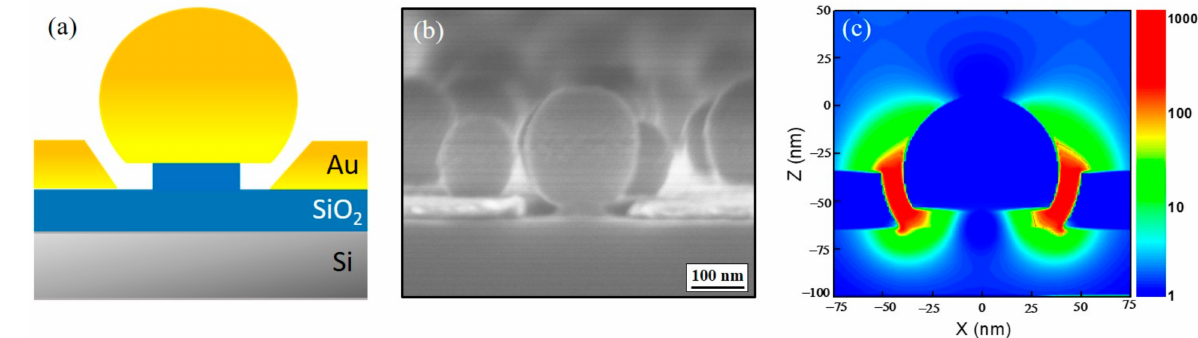
Figure 2. ( a ) Schematic illustration and ( b ) SEM image of an Au nanogap sample. ( c ) FDTD simulation result showing the enhancement of |E| 2 around the nanogap in log scale, where E is the electric